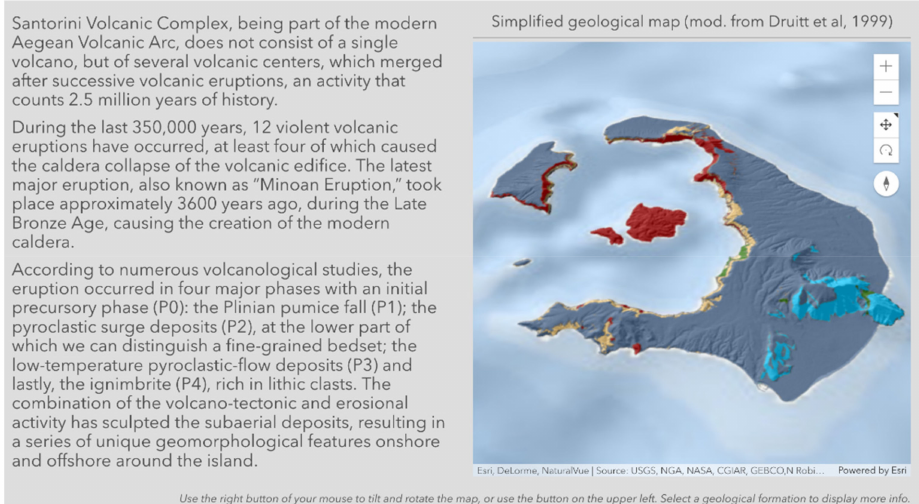
Figure 3. Screenshot showing the part of the hub dedicated to the volcanic history of the island. The users can tilt and rotate the 3D interactive map to view the scene from different points of view. The final part is dedicated to a gallery that includes all nine virtual geosites (Figure